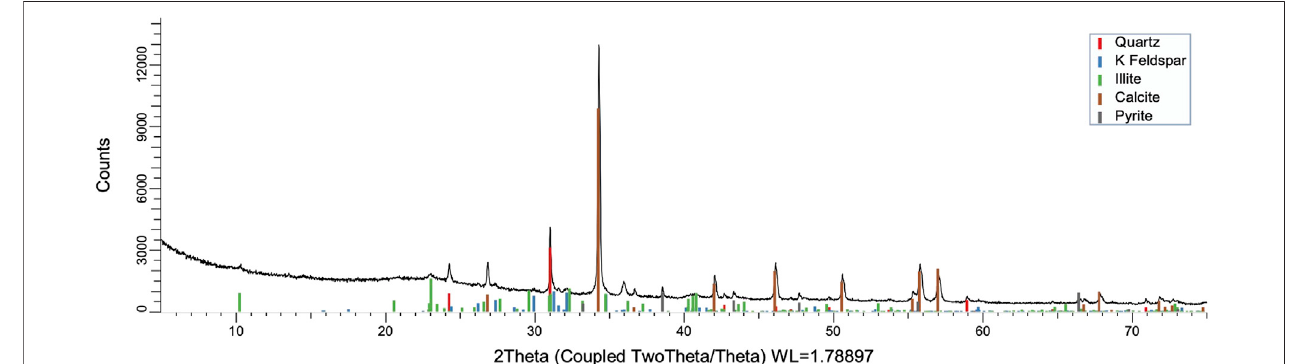
FIGURE 6 | XRD pattern of Estonian oil shale.